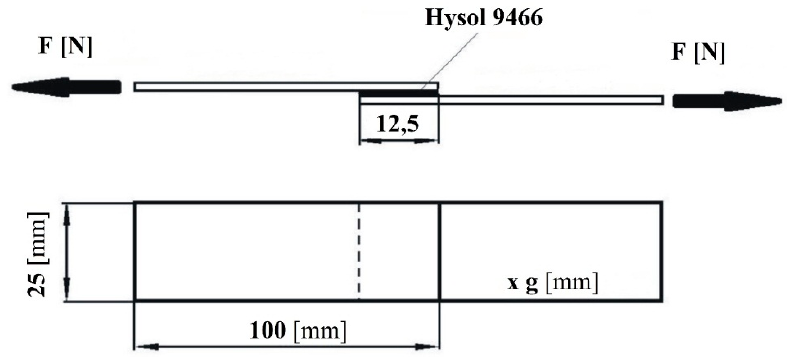
Figure 1. Single-lap adhesive joint: g-adherend thickness, F-force of the joint.